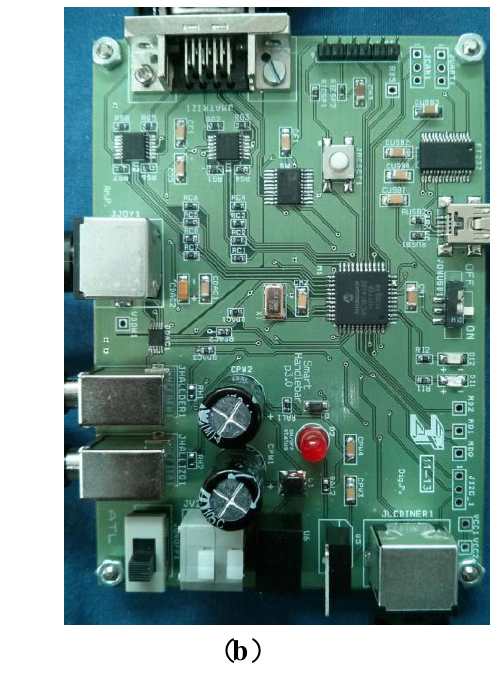
Figure 8. ( a ) Prototype mounted in a power wheelchair; ( b ) Control